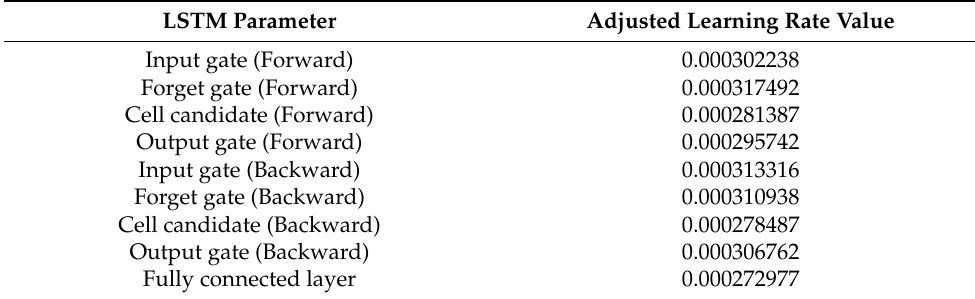
Table 8. The new learning rate values of LSTM parameters (ECG dataset). LSTM